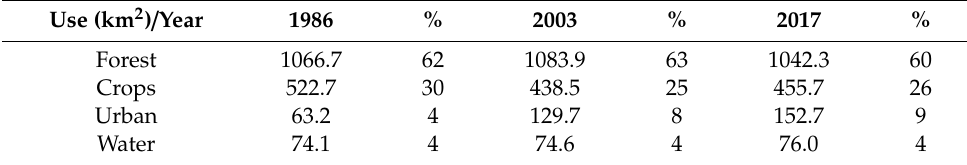
Table 4. Land-use from 1986 to 2050 of Acapulco de Ju á